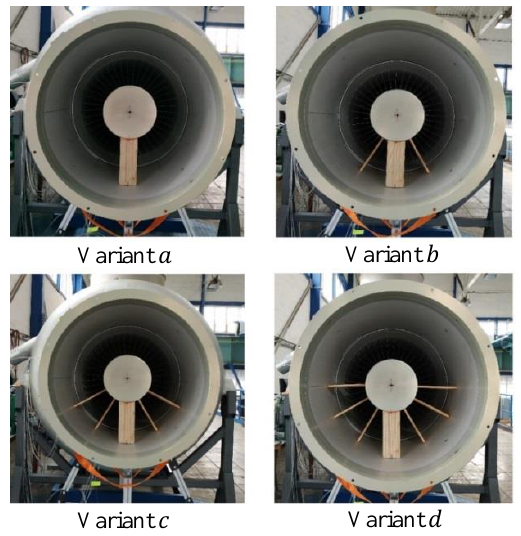
Fig. 19. Measured variants.